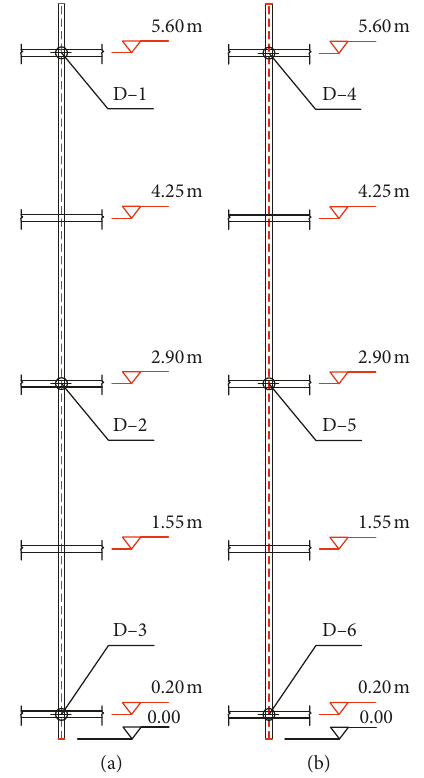
Figure 6: Layout of displacement sensors in Models 1, 2, and 3. (a) A-3 rod. (b) C-6